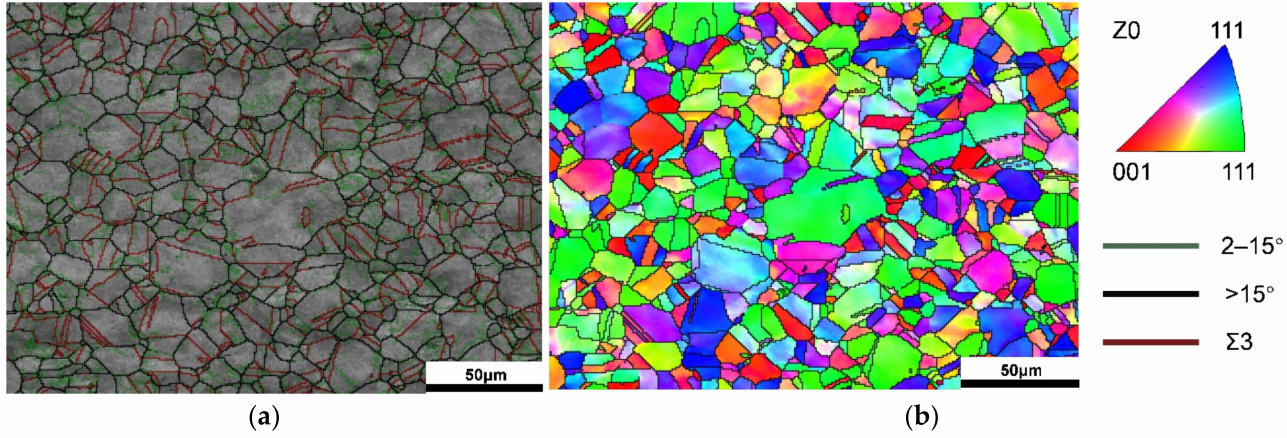
Figure 1. The EBSD Initial microstructures of nickel-based alloy 825: ( a ) boundary coincidence and Σ 3 site lattice boundary map, and ( b ) IPF